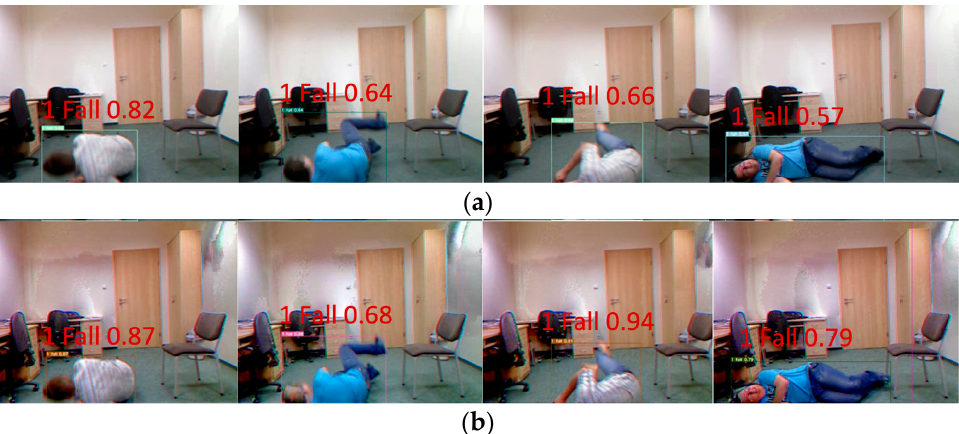
Figure 6. Visual results of object tracking on UR Fall Detection dataset ( a ) YOLOv7 + Deep SORT method ( b ) the proposed method.